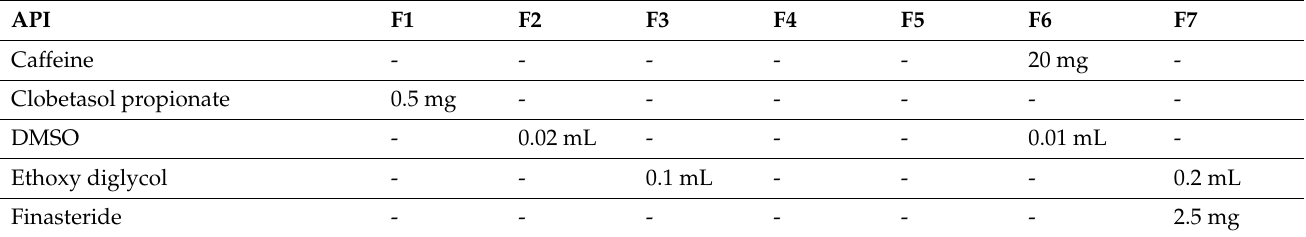
Table 1. Active Pharmaceutical Ingredients Studied and their